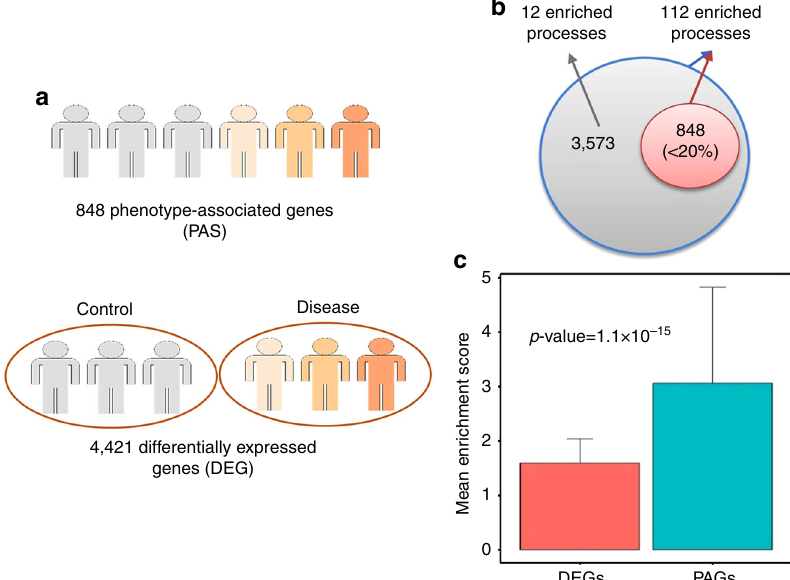
Fig. 2 Comparisons of PAGs with DEGs. a 848 genes are identi fi ed by considering the severity of the disease, while 4421 genes (corrected Limma p < 0.001) are identi fi ed when disease samples with different grades of severity are considered as one group. b PAGs are a small fraction ( < 20%) of DEGs, and they are enriched in the same 112 biological processes as DEGs (Hypergeometric test, corrected p < 0.01). The Figure further shows that the subgroup of DEGs not identi fi ed by the ordinal regression are only enriched in a few biological processes. c The bar plot shows that the mean enrichment score for PAGs is signi fi cantly higher than DEGs (two-tail t -test, p = 1.1 × 10 − 15 ). The horizontal bars show the mean enrichment score of biological processes, and the error bars show the standard